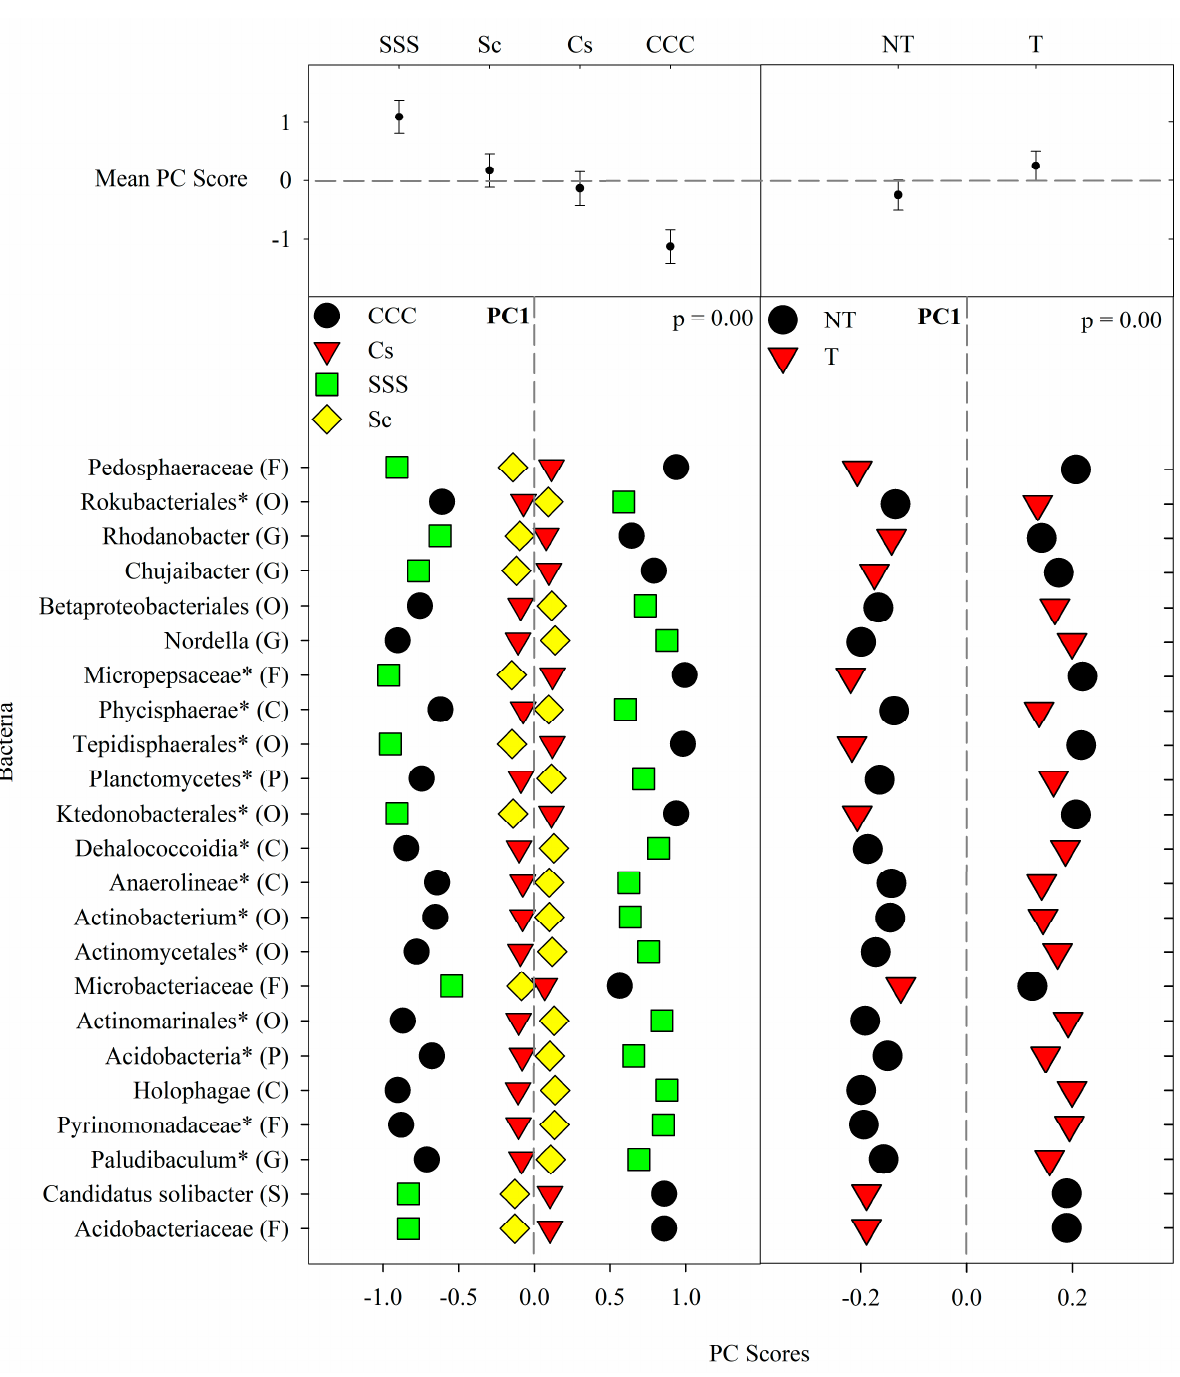
Figure 1. Mean bacterial principal component scores (PC) following 20 years of rotation and tillage treatments. Top panels show the bacterial mean PC score for both crop rotation and tillage main effects for PC1 based on the analysis of variance (ANOVA); error bars represent standard errors of the mean PC scores. Bottom panels show relative abundances (RAs) for each bacterial indicator ASVs by crop rotation and tillage effects. The main effects for PC1 are shown as CCC, continuous corn; Cs, corn phase of the corn-soybean rotation; Sc, soybean phase of the corn-soybean rotation; SSS, continuous soybean; NT, no-till; T, chisel tillage. For each taxon, the response of each ASV was calculated as the mean PC score multiplied by the PC loading score of a given ASV. The y-axes show the name of the ASV’s most explanatory taxonomic rank in parentheses (P, phylum; C, class; O, order; F, family; G, genus; S, species). The “*” after an ASV means it is uncultured.